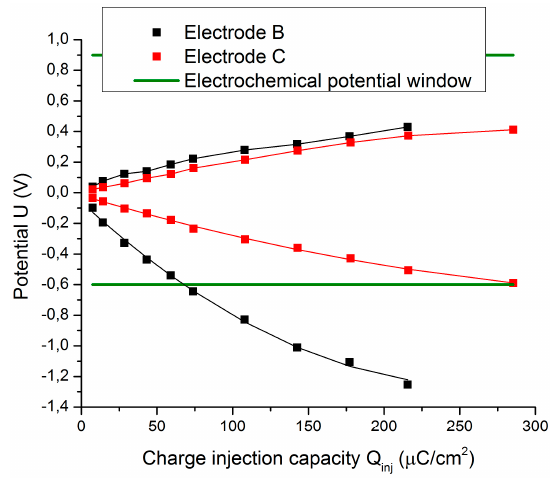
Figure 17. Increase in CIC due to higher surface roughness for a pulse width of 200 µs. Table 4. Results for the three electrodes of this study.